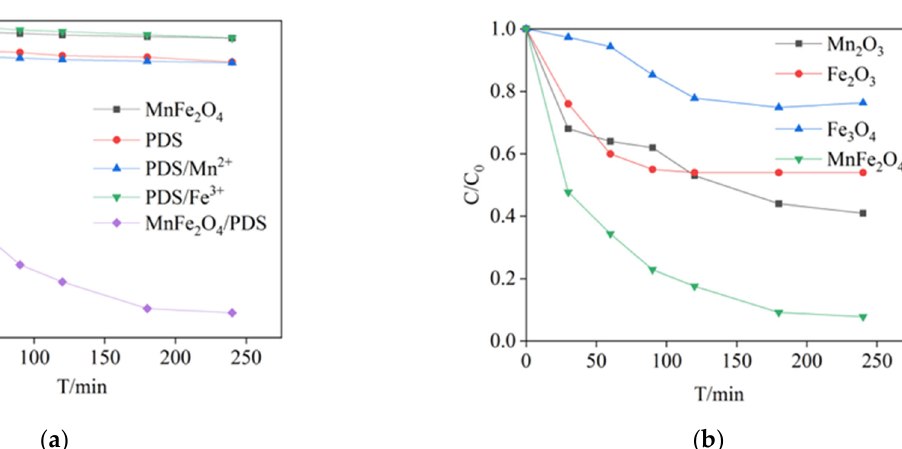
Figure 2. ( a ) Homogeneous and non-homogeneous conditions for degradation of PCA; ( b ) Degradation of PCA by different solid catalysts. Experimental conditions: [PCA] = 20 mg/L, [MnFe 2 O 4 ] = [Fe 2 O 3 ] = [Mn 2 O 3 ] = [Fe 3 O 4 ] = 1.3 g/L, [Fe 3+ ] = [Mn 2+ ] = 5.6 mM, [PDS] = 2.4 mM and pH = 7.00 ± 0.02.